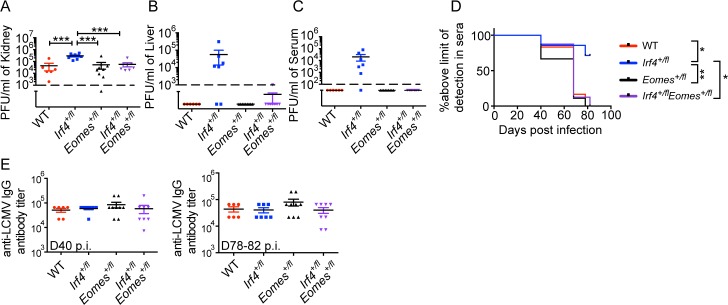

Irf4-Eomes compound haplodeficiency restores virus control during persistent LCMV-clone 13 infection.Kidney (A), livers (B) and sera (C) were harvested from LCMV-clone 13 infected WT, Irf4
+/fl, Eomes+/fl and Irf
+/flEomes+/fl mice between D77-82 post infection and virus titers were determined by plaque assay. Dotted lines indicate the limit of detection. Each data point represents an individual mouse and data are compilations of two independent experiments. (D) Serum was harvested from infected mice at various timepoints post infection. Graph indicates the proportion of mice with viral titers above the limit of detection in serum over time. Each data point represents an individual mouse and data are compilation of two independent experiments; significant differences as determined by Ordinary one-way ANOVA using Tukey’s multiple comparison test (A) and Log-rank (Mantel-Cox) test (D). E) Anti-LCMV IgG antibody titers in sera at D40 and D78-82 p.i. were determined. For D40 timepoint, data points corresponding to 3 WT and 4 Irf4
+/fl mice were previously shown in Fig 5E. Each data point represents an individual mouse and data are a compilation of two independent experiments; significant differences determined by Ordinary one-way ANOVA using Tukey’s multiple comparison test.